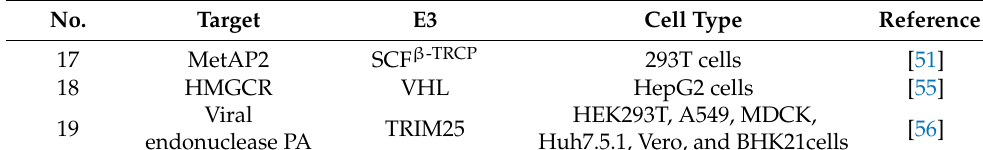
Table 8. Natural product targets 17–19.